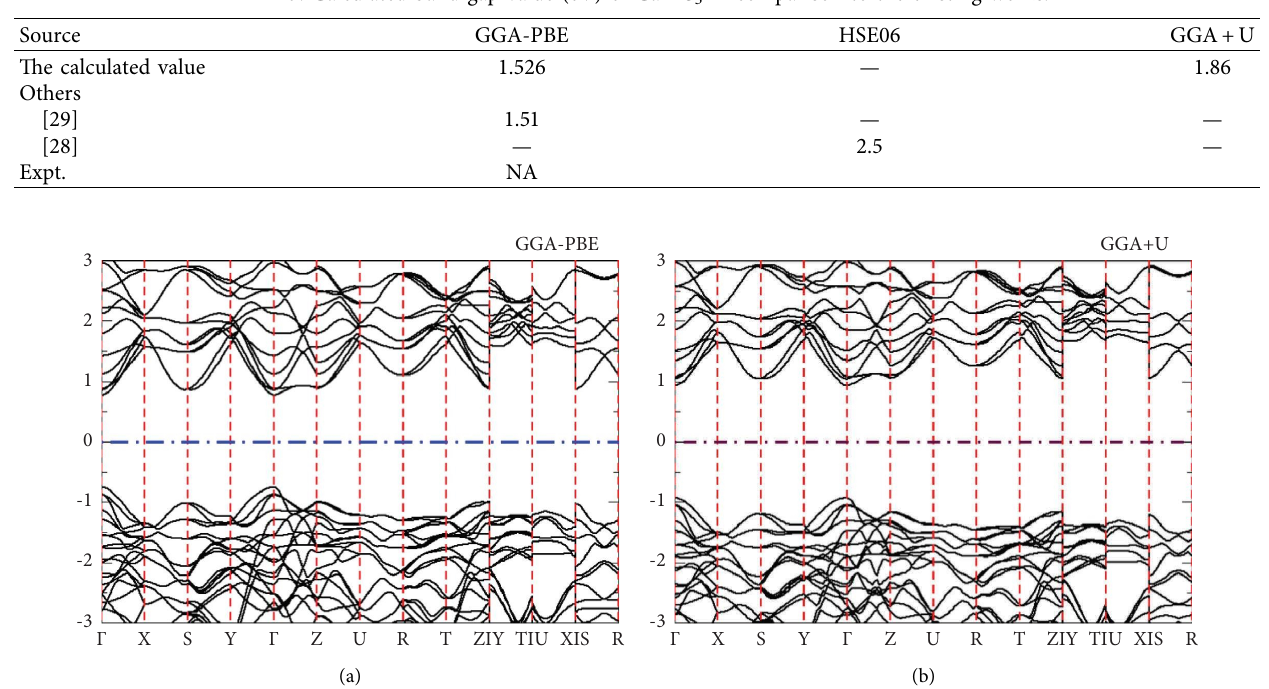
Figure 2: Band structure of CaHfS 3 with respect to GGA-PBE (a) and GGA +U (b).